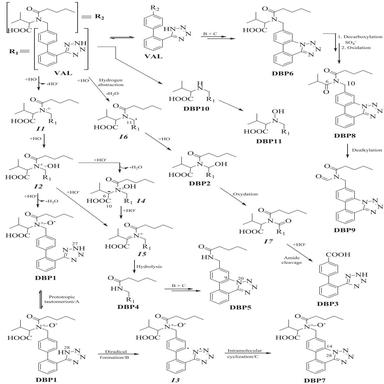
Plausible mechanism for the formation of DBP1–DBP11.